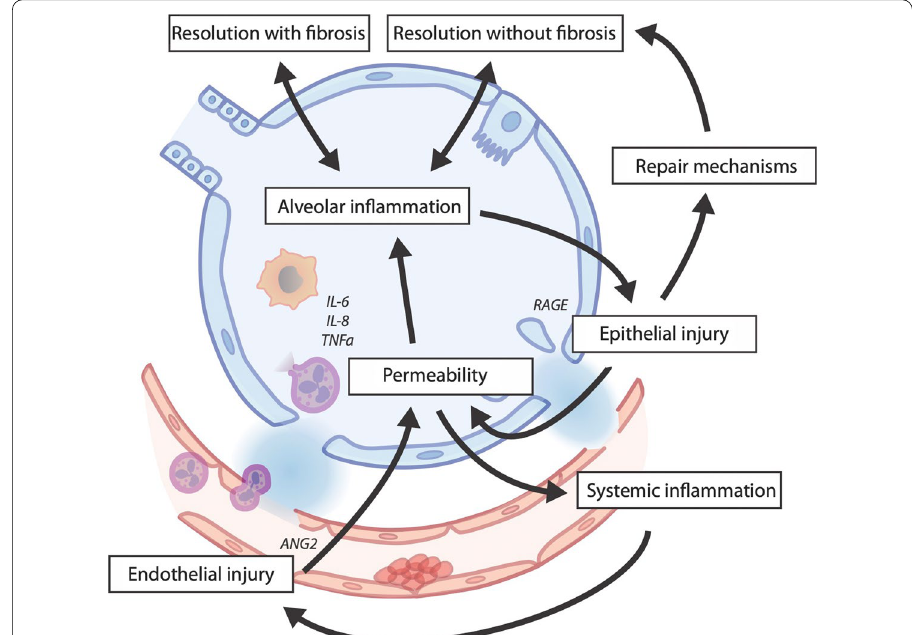
Fig. 2 Biological integration of potential treatable traits. The described domains of biological variation do not exist in isolation of each other (Fig. 1). An individual patient could, therefore, be classified according to a conceptional framework that evaluates the three major components of an alveolar unit (endothelium, interstitium with extra‑cellular matrix, and epithelium) and the balance of host response between alveolar and blood compartment [71]. We speculate that the position of an individual, based on information pertaining to these component parts in alveolar fluid relative to the circulation, becomes critical